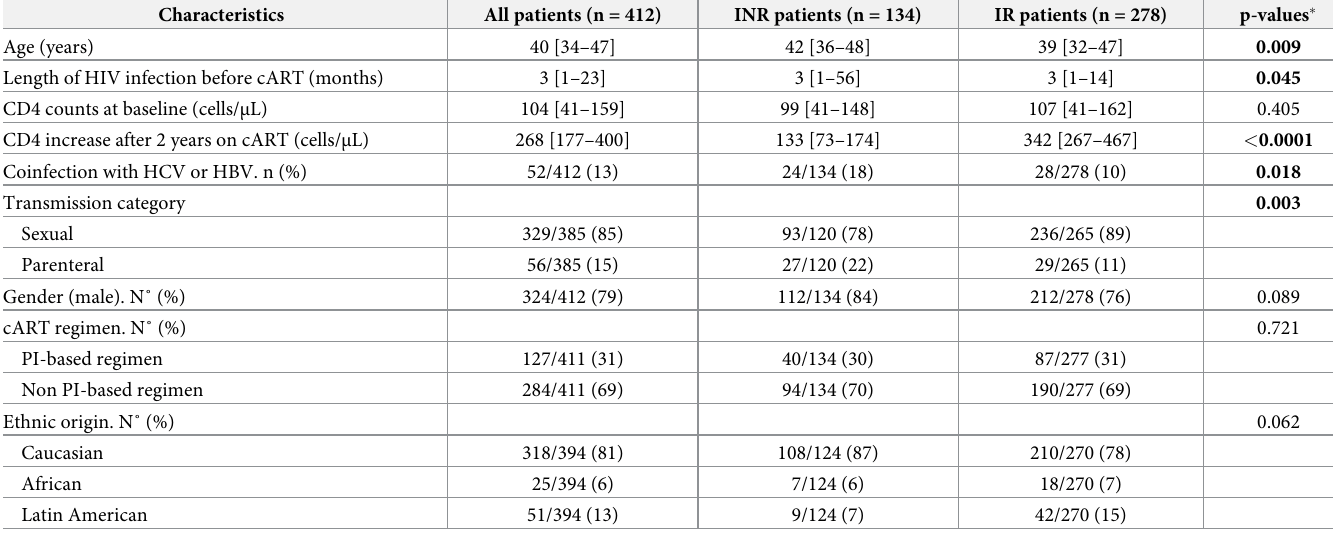
Table 1. Characteristics of study population.